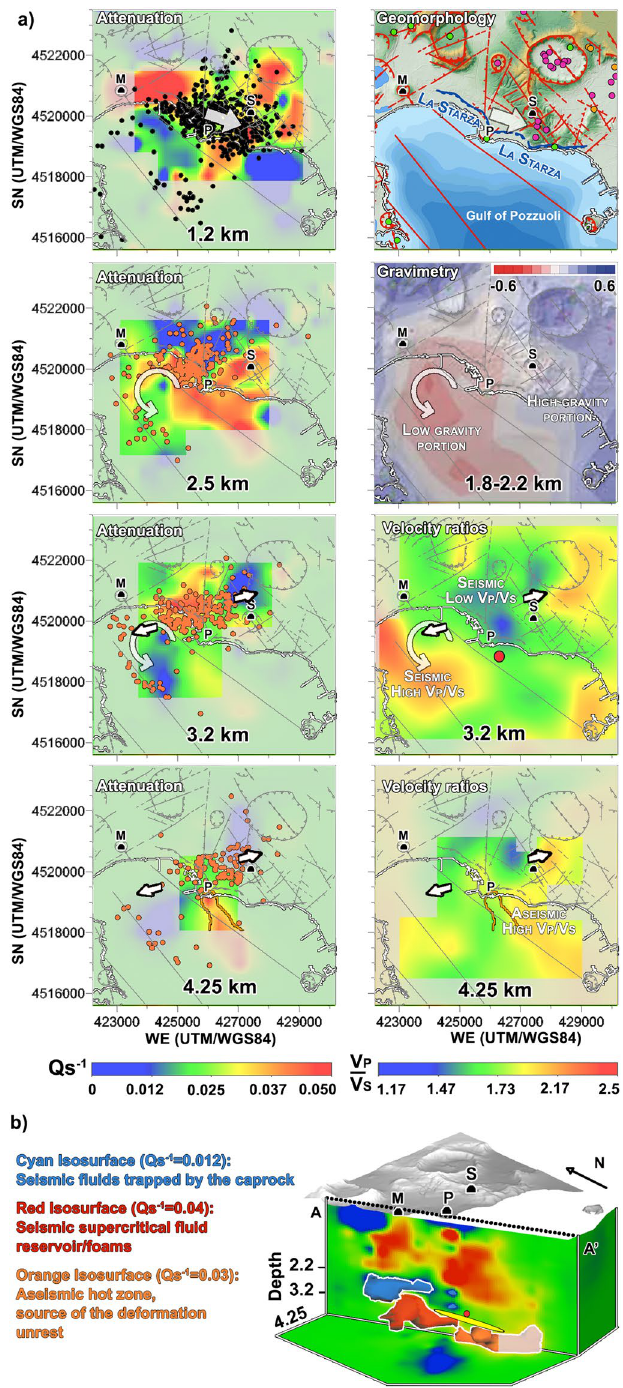
p ratios. V s p models. ( a ) Left hand V s p ratios (3.2 and 4.25 km 24 ). The red circle V s